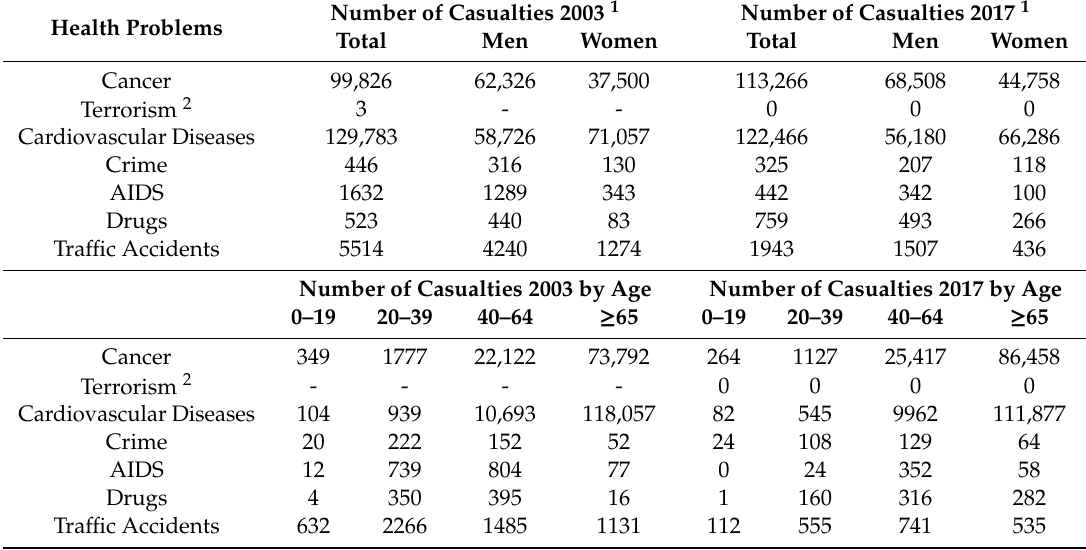
Table 6. Deaths due to social and health problems in Spain in 2003 and